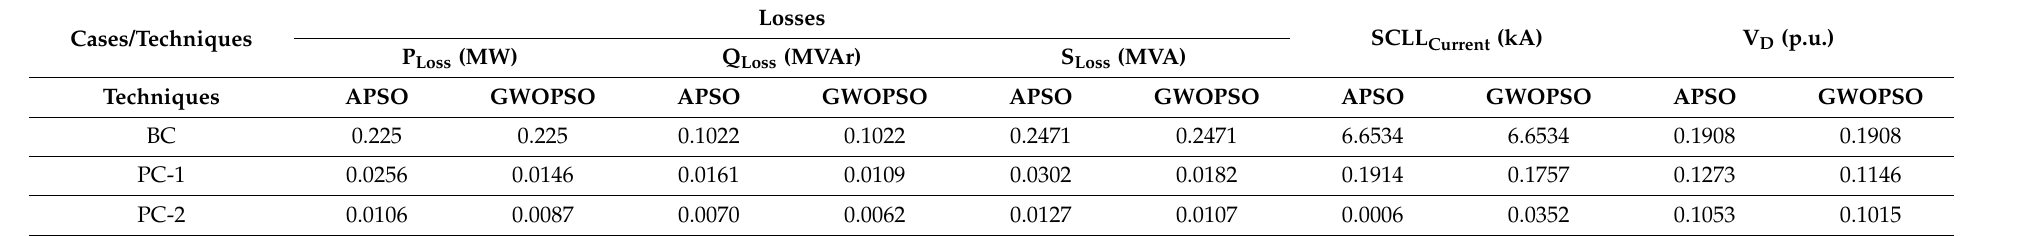
Table 11. Losses, Short Circuit Level of Line Current (SCLL Current ), Deviation in Voltage (V D ) of the 69-bus